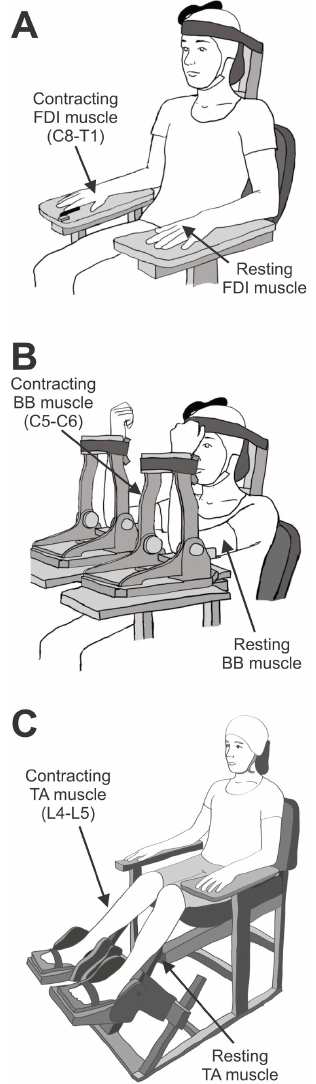
Figure 1. Experimental Set-up. Diagrams show the posture of the hand, elbow, and foot used during testing. Three motor tasks were randomly tested. In task 1 (A), subjects were seated in an armchair with both arms flexed at the elbow by 90° with the forearm pronated and the wrist and forearm restrained by straps. In this task, crossed motor evoked potential (MEP) facilitation was examined in the first dorsal interosseous (FD, motoneurons located at C8-T1) muscle. In task 2 (B), subjects were seated in an armchair with both shoulders and elbows flexed by 90°. In this task crossed MEP facilitation in the biceps brachii (BB, motoneurons located at C5-C6) muscle was tested. In task 3 (C), subjects were seated in an armchair with both feet attached to a footplate. Here crossed MEP facilitation was tested in the tibialis anterior (TA, motoneurons located at L4-L5) muscle. During all tasks subjects were at rest while the contralateral side remained at rest or performed 70% of MVC into index finger abduction (A), elbow flexion (B), and ankle dorsiflexion